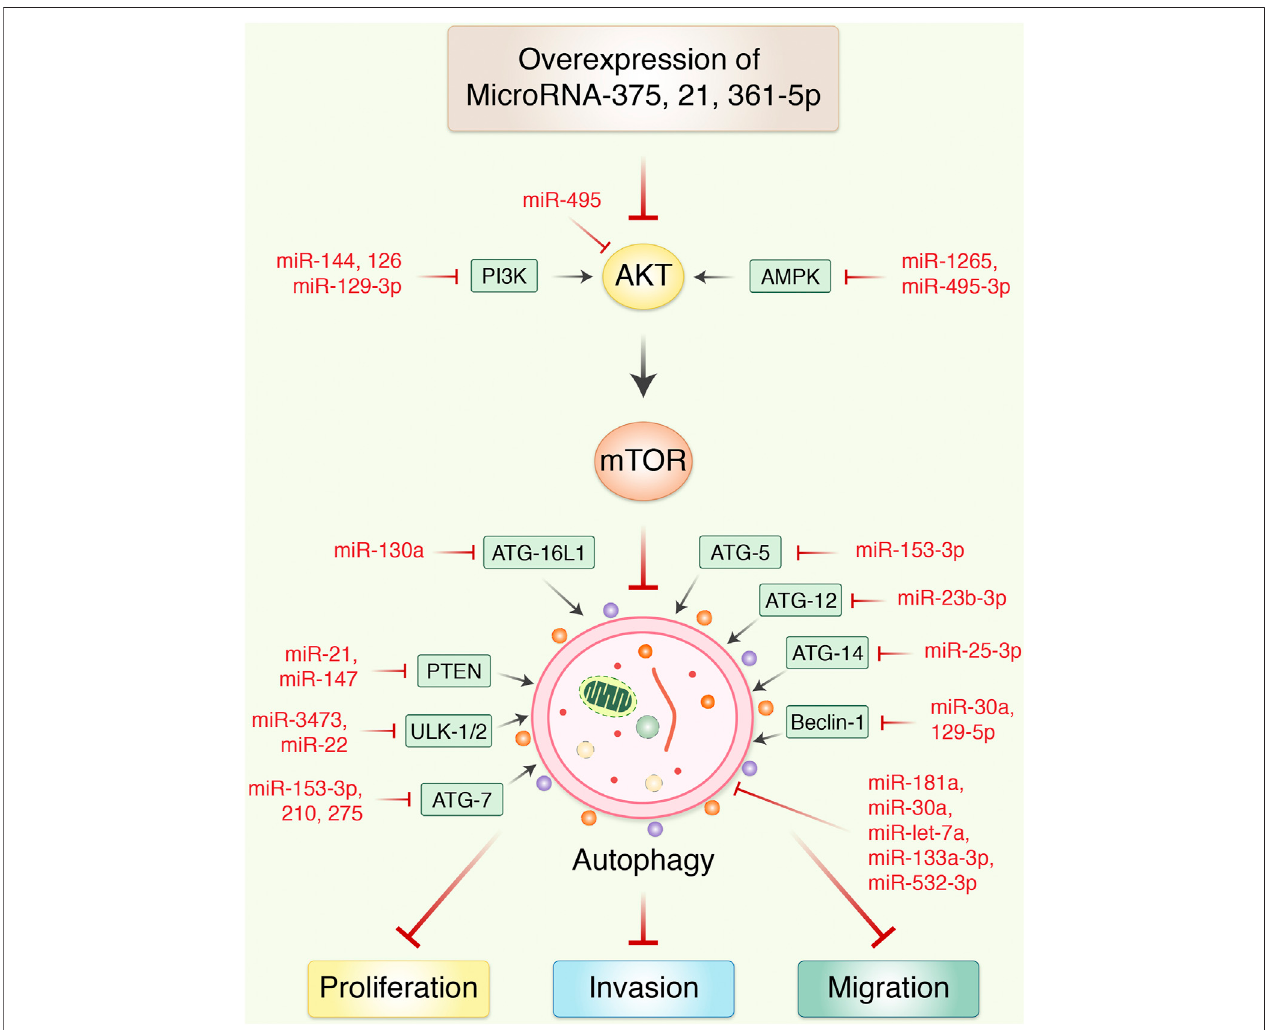
FIGURE 3 | MicroRNAs regulates autophagy-mediated cell proliferation and migration in gastric cancer. Overexpression of miR-375 inhibited the proliferation and migration of gastric cancer in vitro and xenograft nude mouse model. miRNA blocks autophagy via AKT/mTOR signaling pathway and regulating invasion as well as migrationinepithelial-to-mesenchymaltransition.Inaddition,mostusuallyeffectivemiRNAscontrolthetranscriptionalexpressionofupstreamactivatorsandinhibitorsof autophagy in gastric cancer.